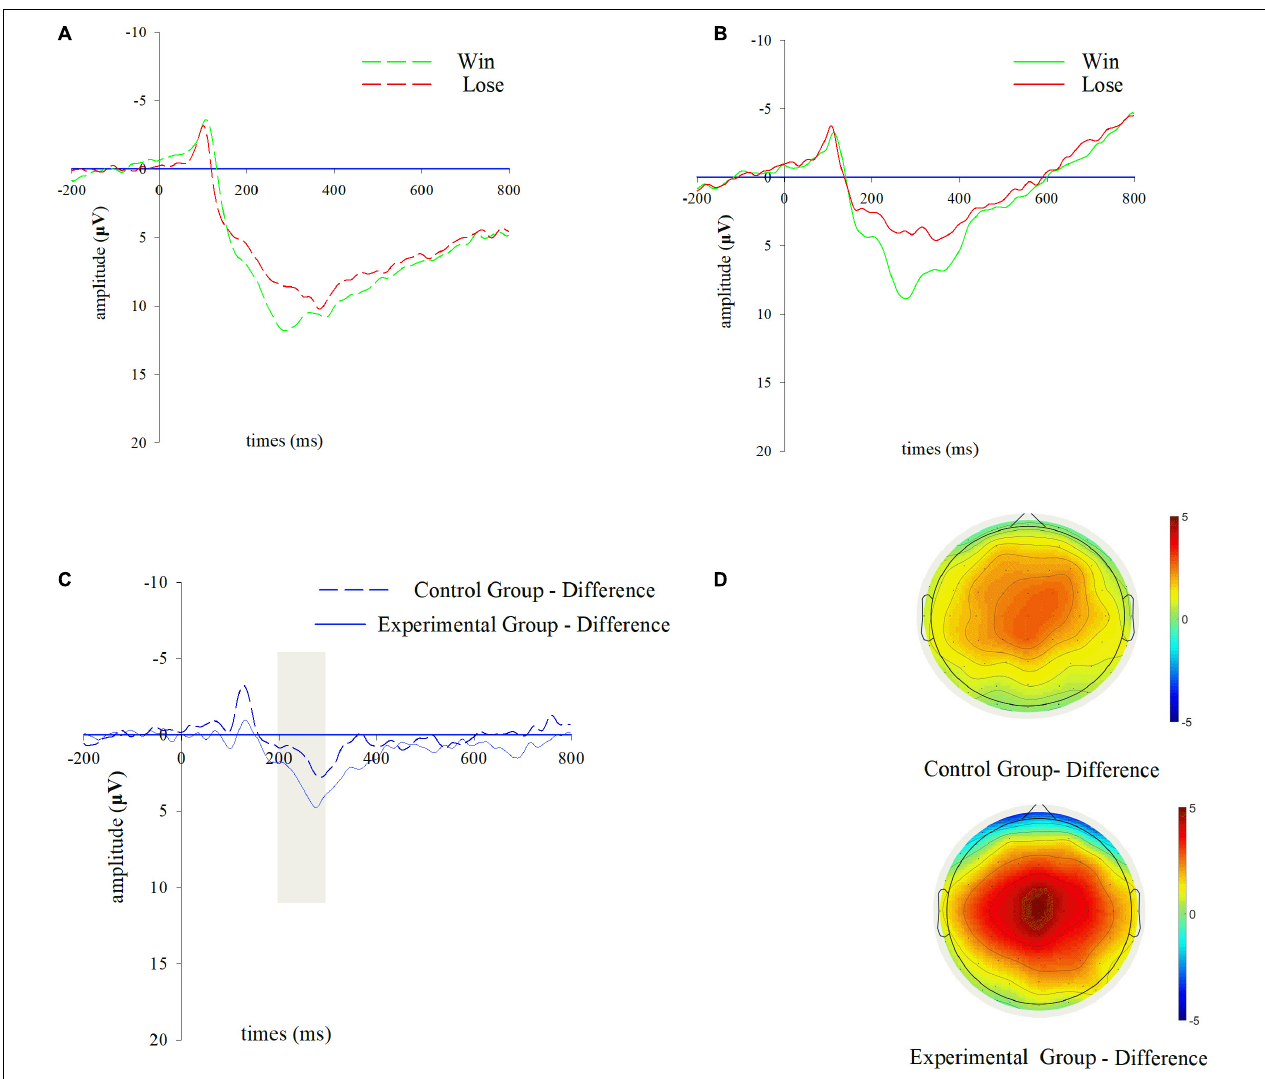
FIGURE 2 | RewP results during outcome evaluation. Grand-averaged ERP waveforms of RewP for wins and losses from the chosen electrode cluster (F1, FZ, F2, FC1, FCZ, FC2, C1, CZ, C2) for (A) the control group, and (B) the experimental group. (C) Difference waves of RewP (win-lose) from the chosen electrode cluster for two groups. (D) The scalp topographies of difference waves of RewP for two groups, and the bar for the topographic map ranges from –5 to 5 µ V.